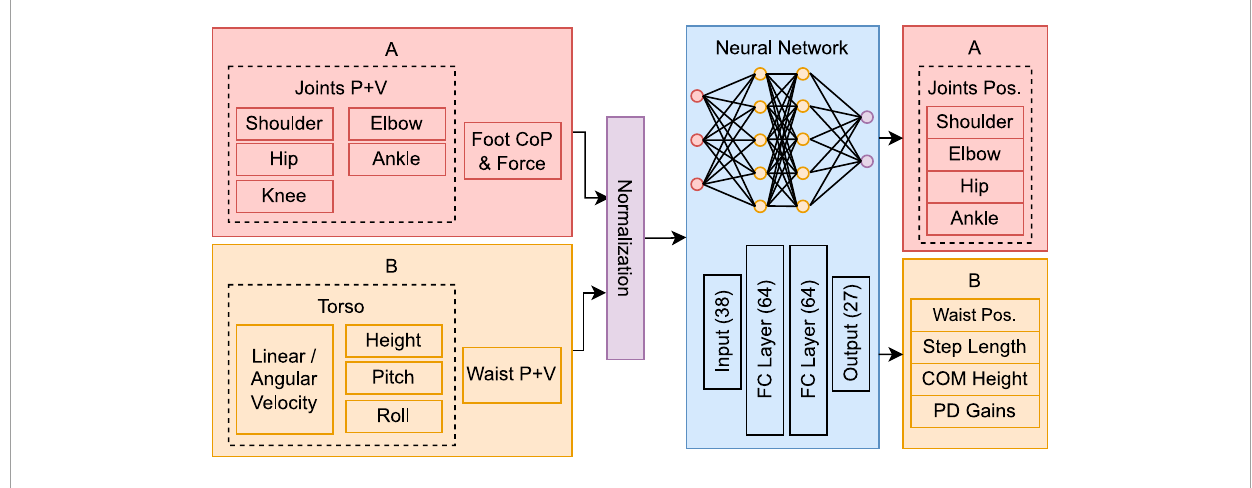
FIGURE 3 Network architecture, system space parameters and symmetry transformation groups used for data augmentation: (A) reflection symmetry transformation and (B) no transformation or inversion.